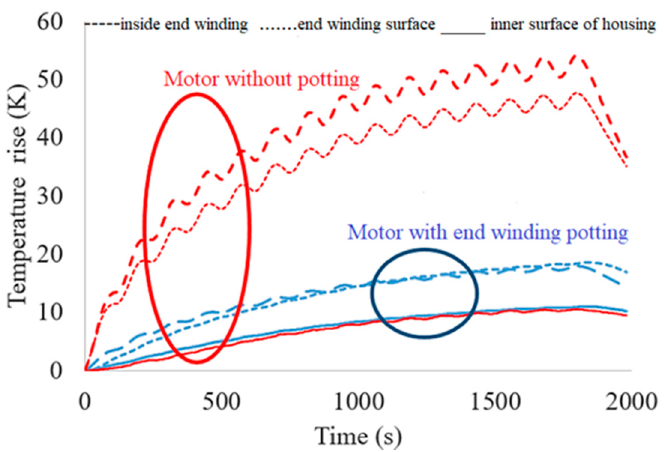
Figure 33. Rise in temperature with and without end winding potting [57].